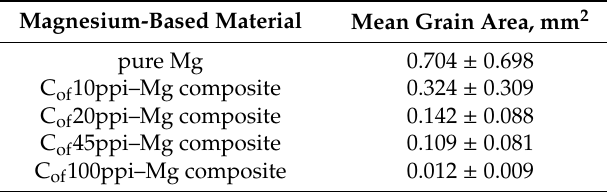
Figure 5. Light microscope (LM) micrographs of etched composites, initial images for quantitative analysis of magnesium grain size ( a ) C of 10ppi, ( b ) C of 20ppi, ( c ) C of 45ppi, ( d ) C of 100ppi. Table 3. Results of α -Mg mean grain area measurements in a composite matrix with di ff erent C of porosities and reference magnesium